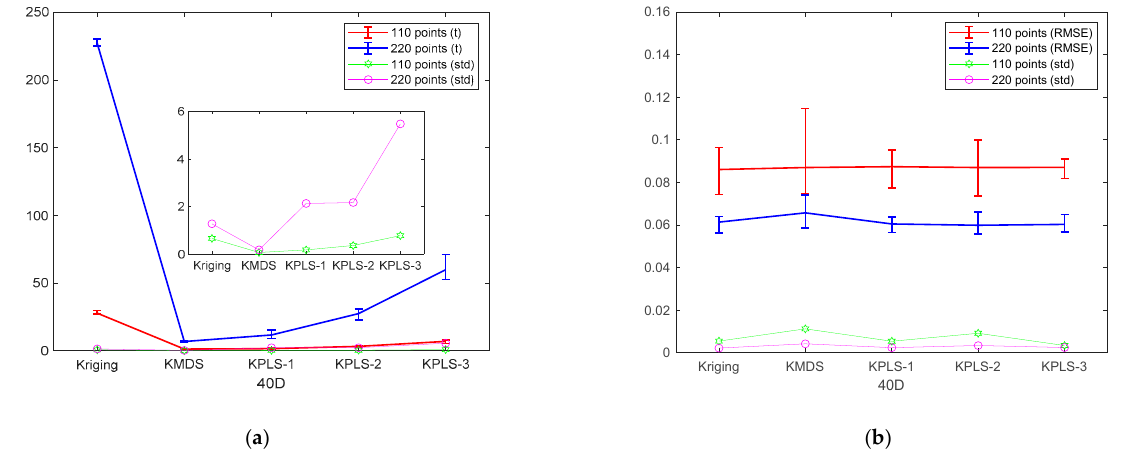
Figure 11. ( a ) Modeling time and its standard deviation for the 40D Michalewicz function. ( b ) RMSE and its standard deviation for the 40D Michalewicz function.